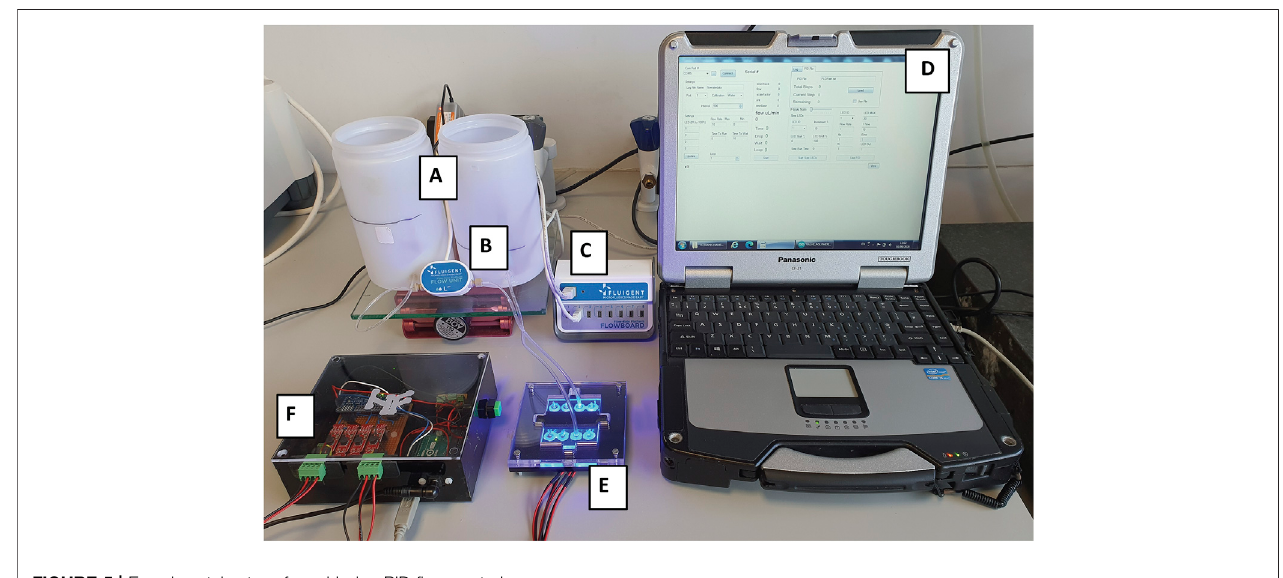
FIGURE 5 | Experimental set-up for achieving PID fl ow control.